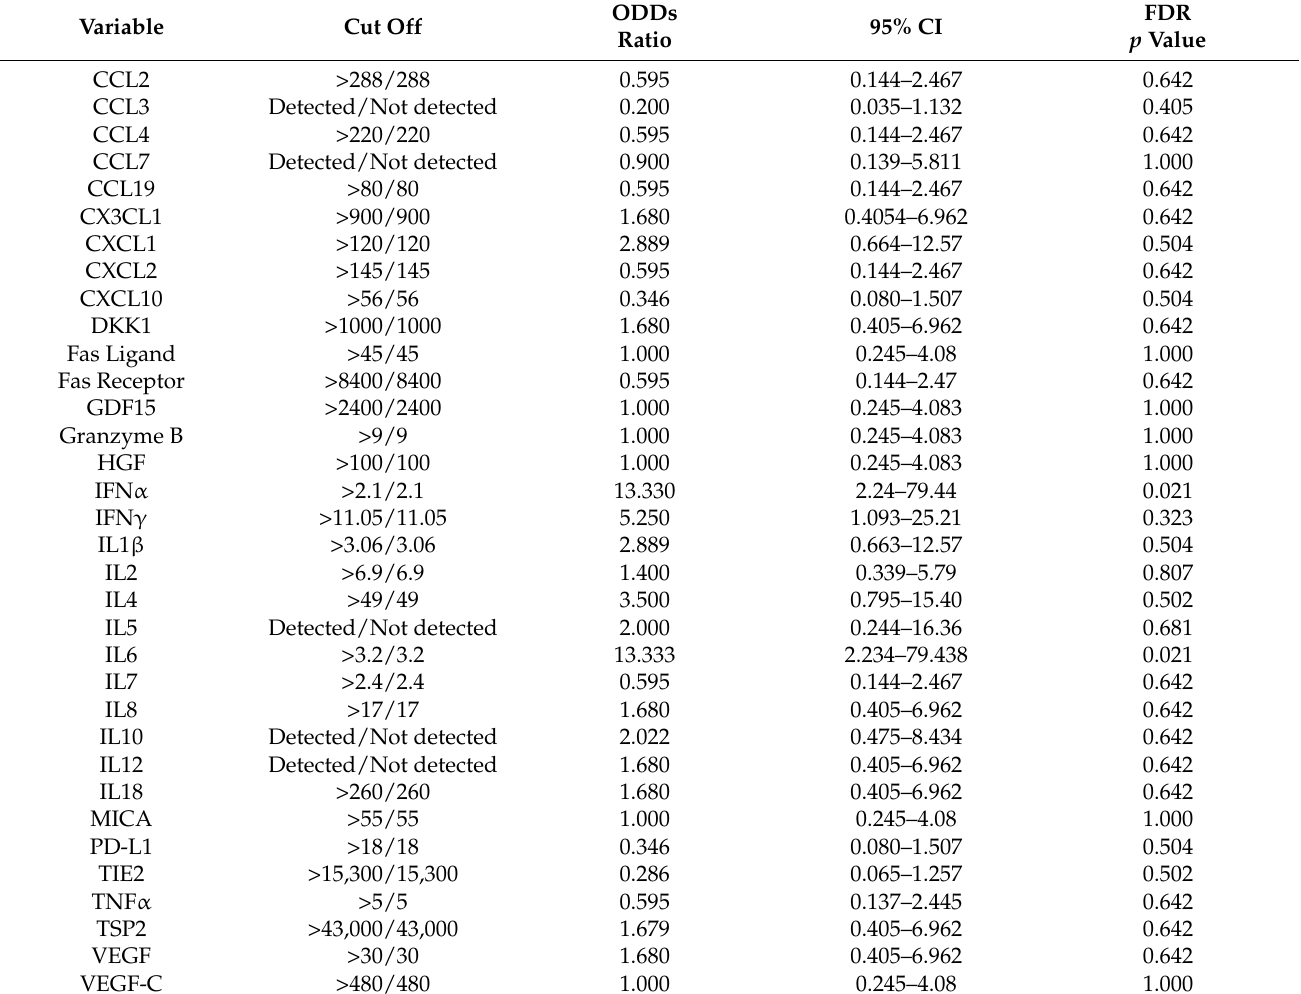
Table 1. Logistic regression analysis of factors related to progressive